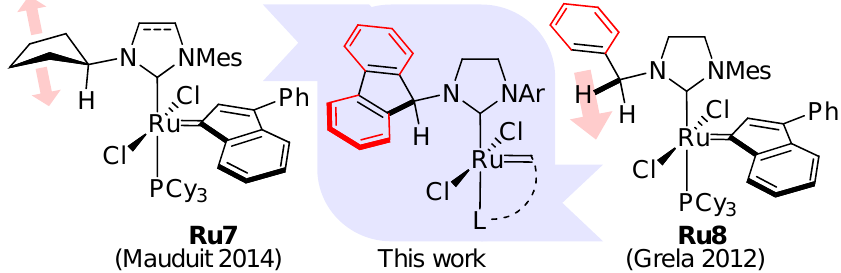
Figure 2. Combined structural characteristics leading to development of a new system (the arrows symbolize the direction of the planned steric enlargement).